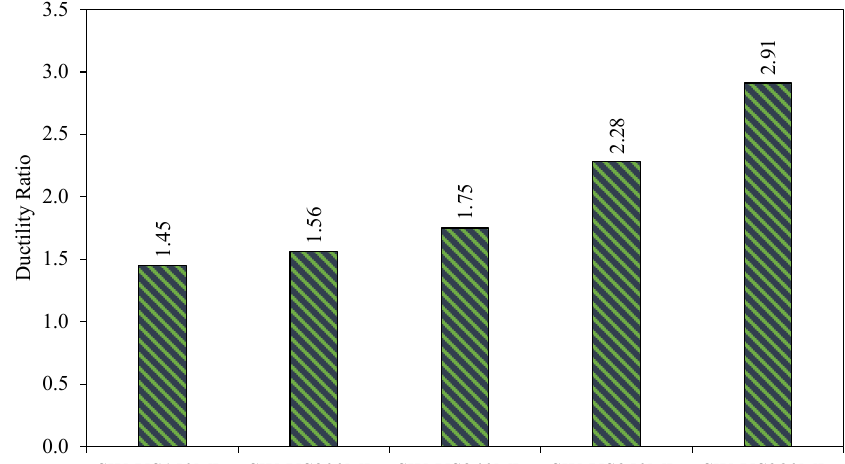
Figure 21. Ductility ratio of group 3.